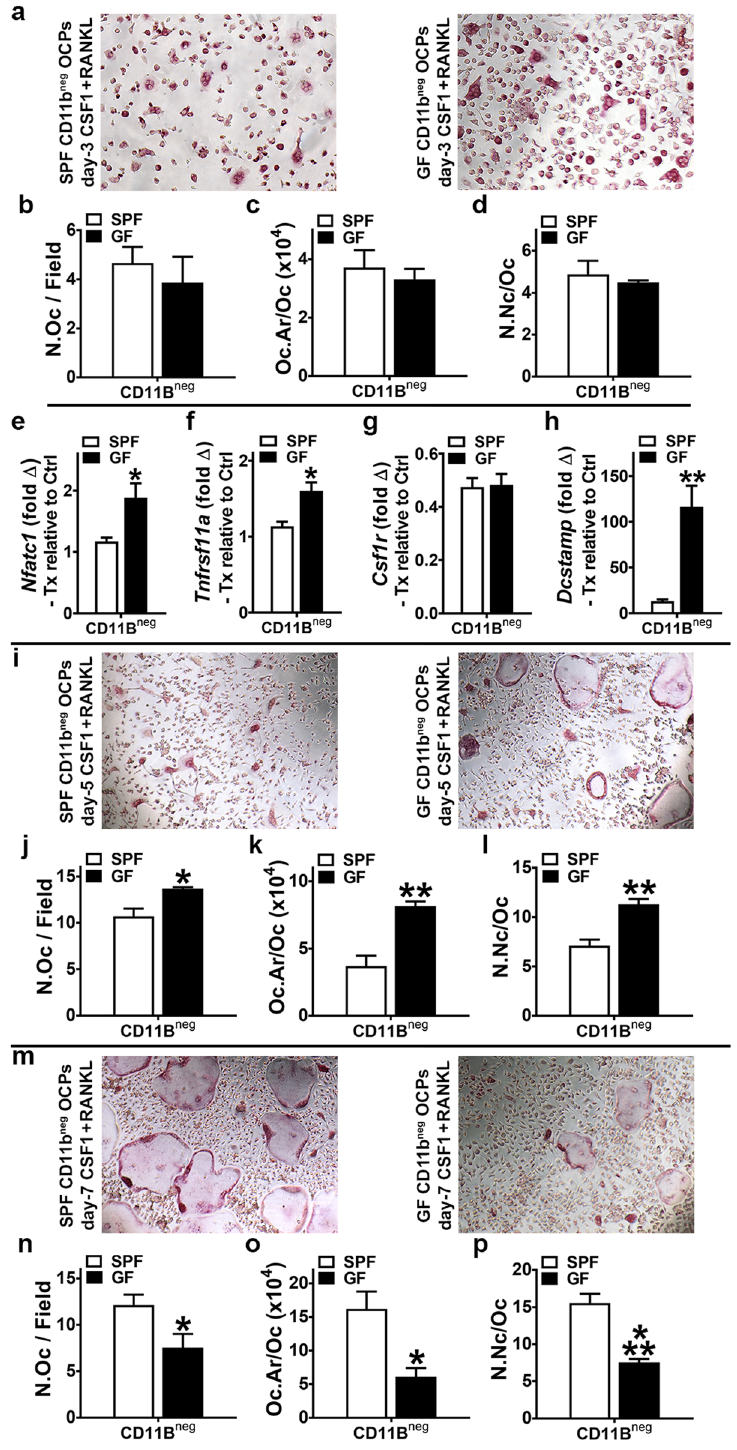
Figure 4. Osteoclast-precursor (OCP) differentiation assays. ( a – p ) 11 week-old male SPF & GF mice were euthanized; bone marrow harvested; hematopoietic progenitor cells (HPCs) isolated. Magnetic cell sorting was applied to separate CD11b neg HPCs, which were then stimulated in culture (primed with CSF1) to enrich for CD11b neg osteoclast-precursor (OCP) cells having high osteoclastic potential. CD11b neg OCP cultures were then stimulated with control (CSF1 alone) or treatment (CSF1 & RANKL) media for 3, 5 and 7 days. Cytomorphometric cellular differentiation endpoints were analyzed in TRAP stained CD11b neg OCP cultures at day-3, day-5, and day-7 to evaluate cell level alterations in RANKL-induced osteoclast differentiation; TRAP + cell with > 3 nuclei considered an osteoclast. Gene expression studies were carried out in CD11b neg OCP cultures at day-3 to detect early transcription level alterations in RANKL-stimulated osteoclast differentiation. ( a – d ) Day-3 TRAP stain assay (n = 4/gp). ( a ) Representative images (200X) of CD11b neg